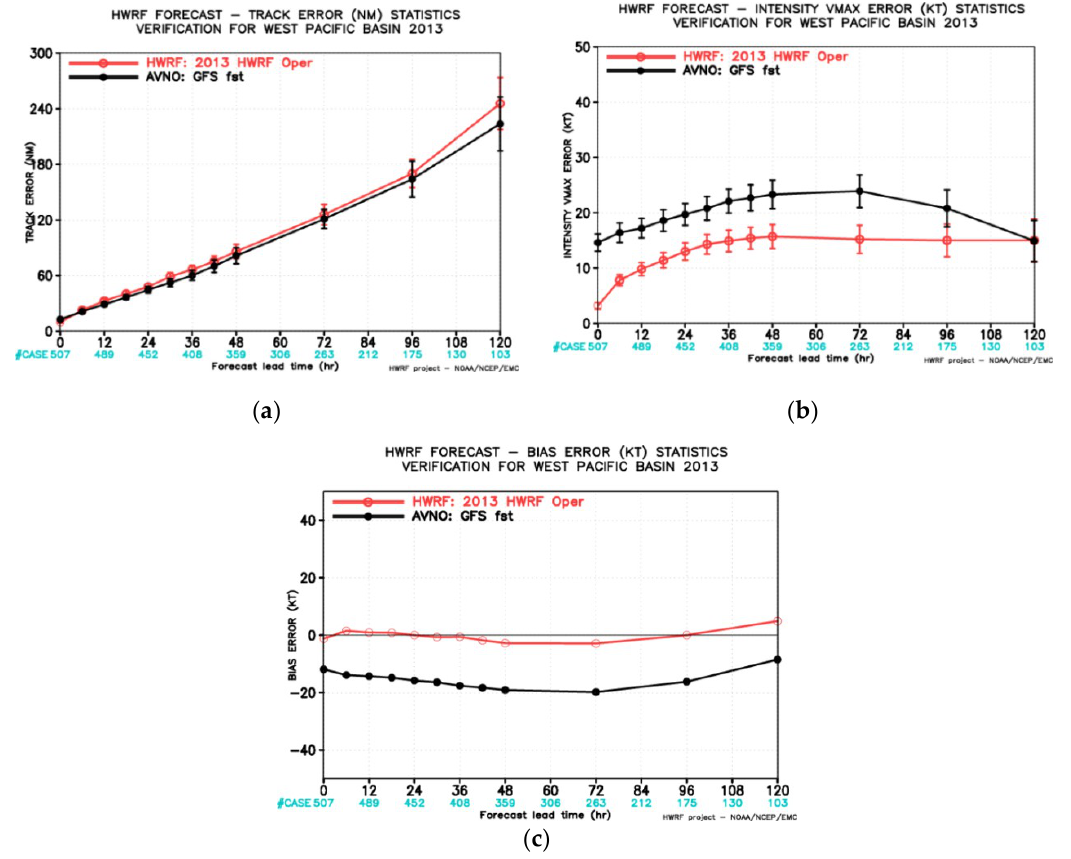
Figure 7. ( a – c ). Statistics of the typhoon forecasts in Western Pacific basin in 2013 hurricane season real-time run. Red line is for HWRF, black line is for GFS. ( a ): track forecasts; ( b ): intensity forecasts; ( c ): Bias of intensity forecasts.